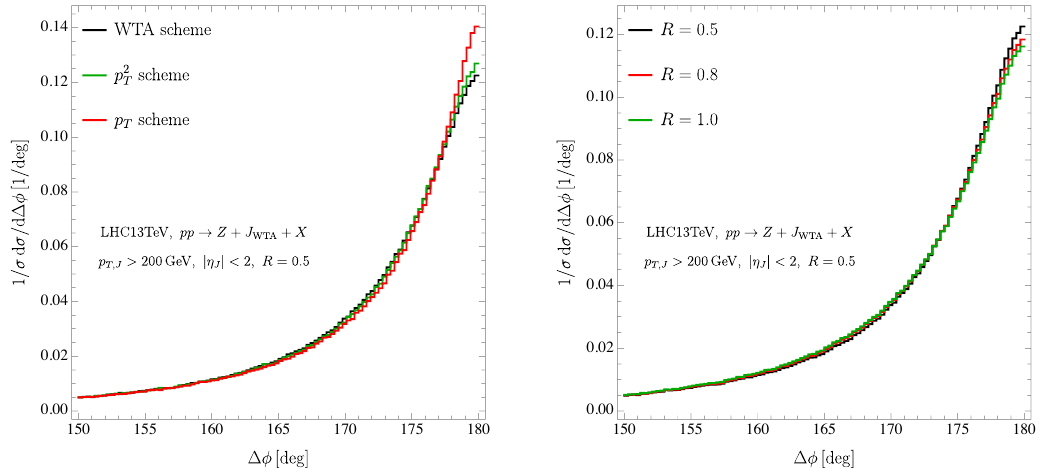
Figure 11. Normalized ∆ φ distribution for Z +jet in Pythia . Left: for WTA, p 2 recombination schemes. Right: for WTA with jet radii R = 0 . 5 , 0 . 8 and 1 . 0 . Our factorization predicts that the cross section is independent of R if δφ (cid:28) R